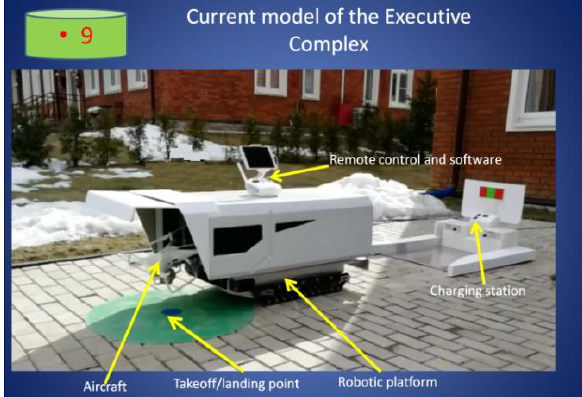
Figure 2. Appearance of the Executive